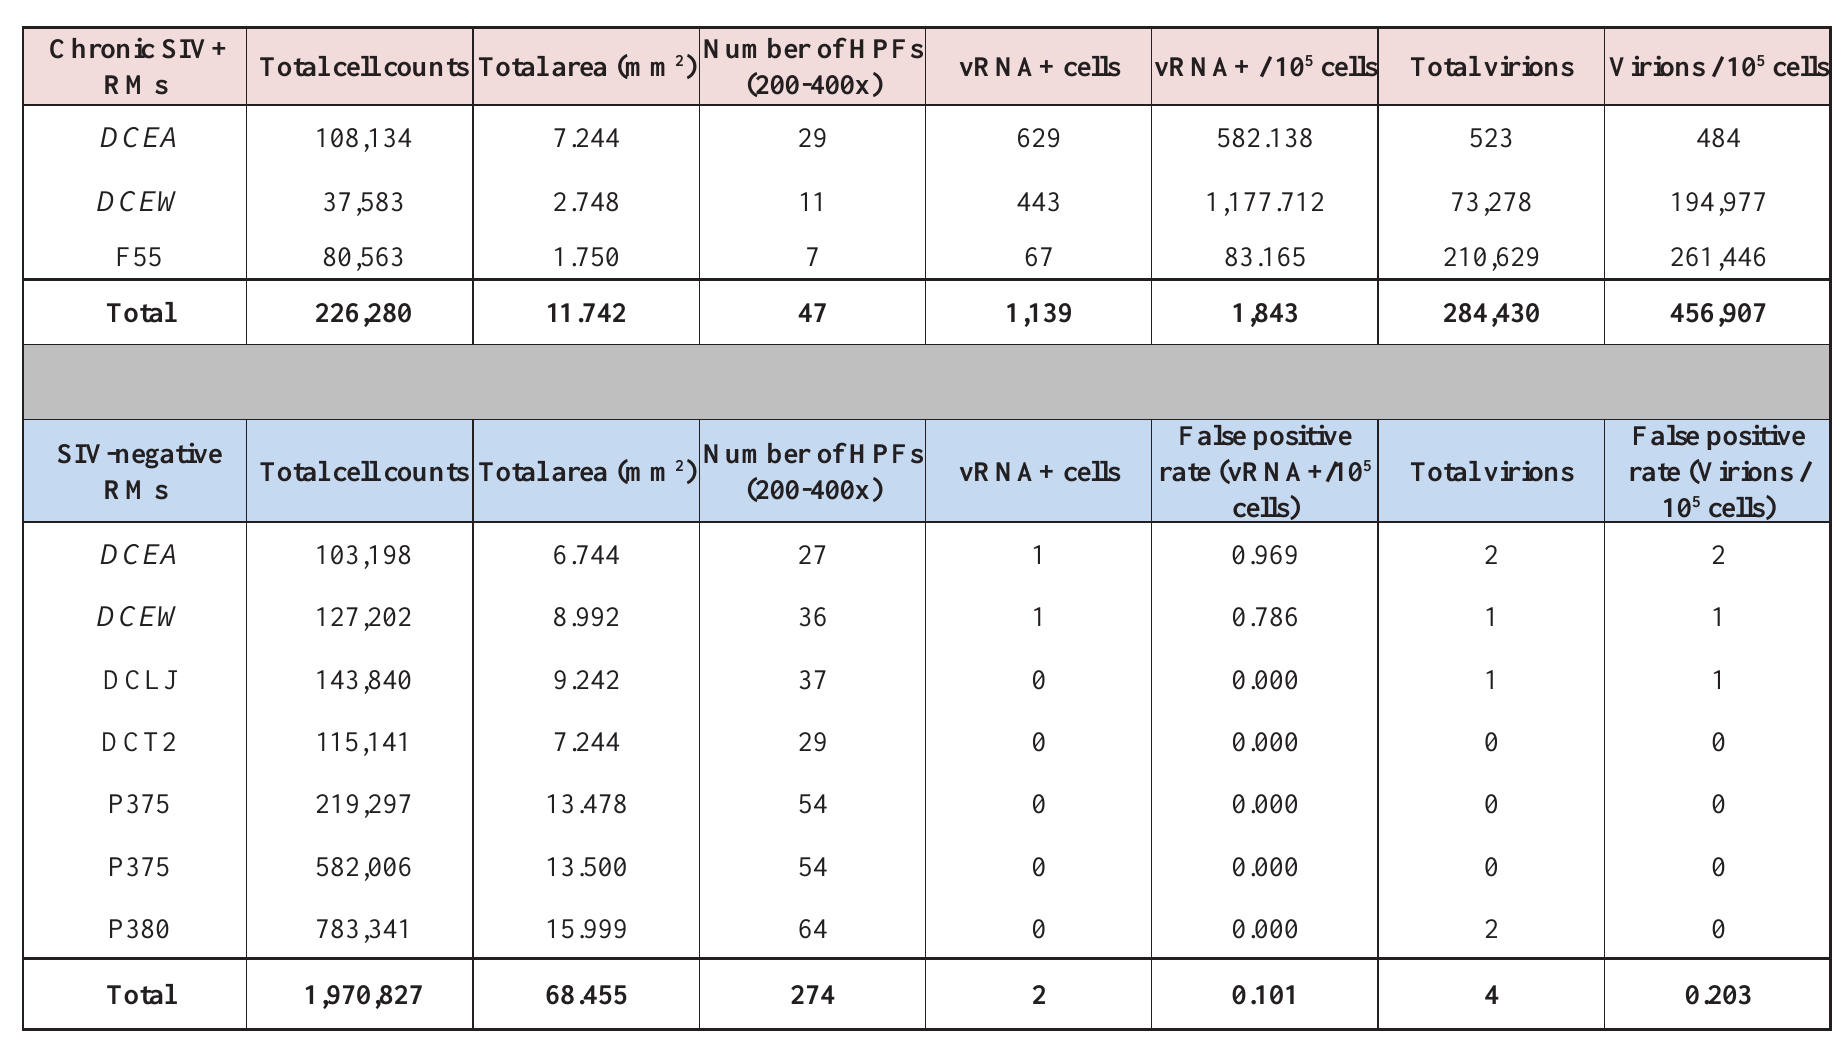
Supplemental Table 1. Rate of false-positive detection for vRNA+ cells and virions by